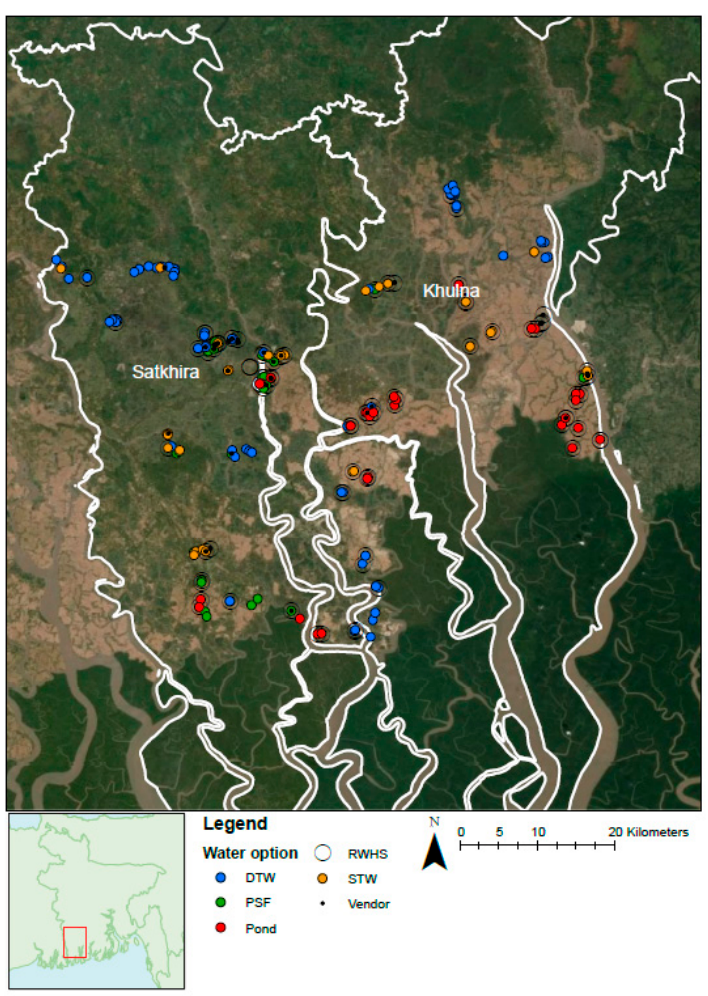
Figure 1. Locations of the surveys throughout the region. The symbols and colours indicate the water options related to the survey. DTW = deep tubewell; PSF = pond sand filter; RWHS = rainwater harvesting system; STW = shallow tubewell.